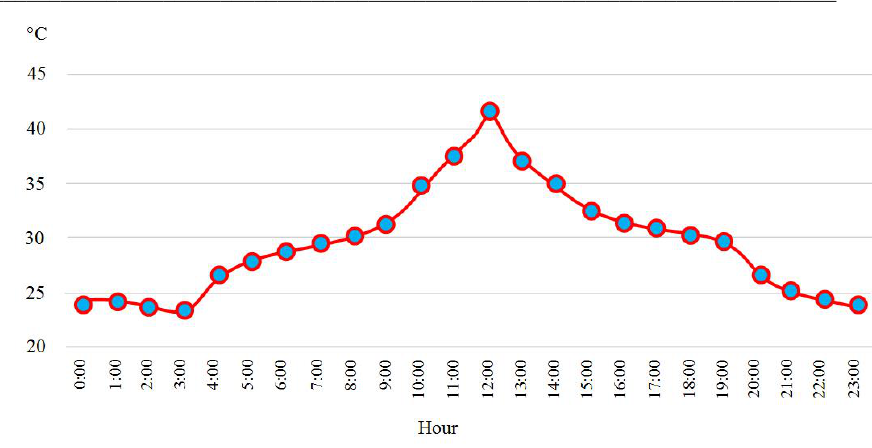
Fig. 5. The hourly surface temperature of a façade near the micro weather station (MWC) installation on US Street measured on May 18.